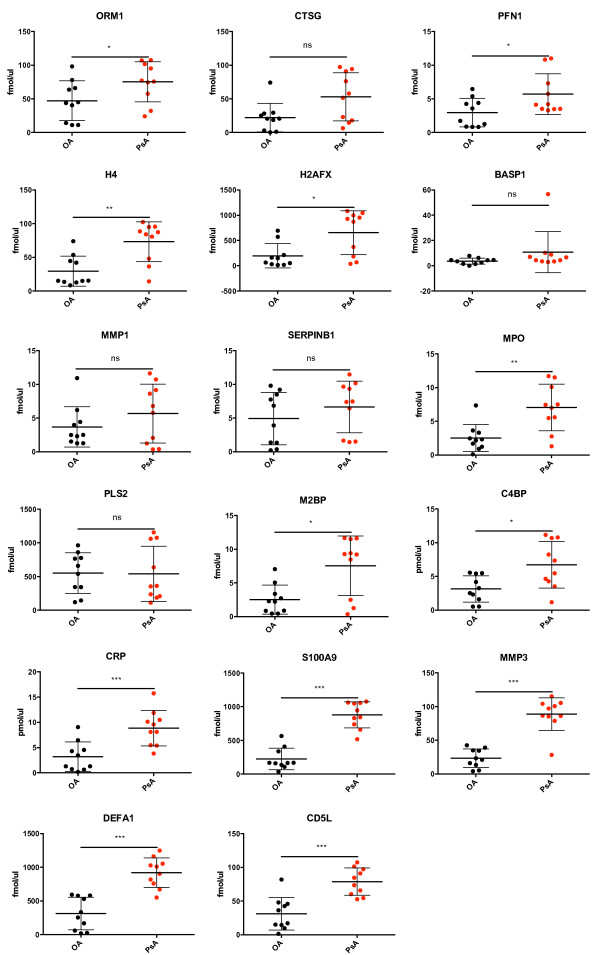
Verification and concentration of elevated proteins in PsA synovial fluid (Set II) by selected reaction monitoring assays, normalized against heavy-labeled peptides. Symbols represent SF samples from individual subjects; horizontal lines depict the mean, and vertical lines the standard deviation. ****Indicates P < 0.0001; ***P < 0.001; **P < 0.01; *P < 0.05; ns: non-significant.